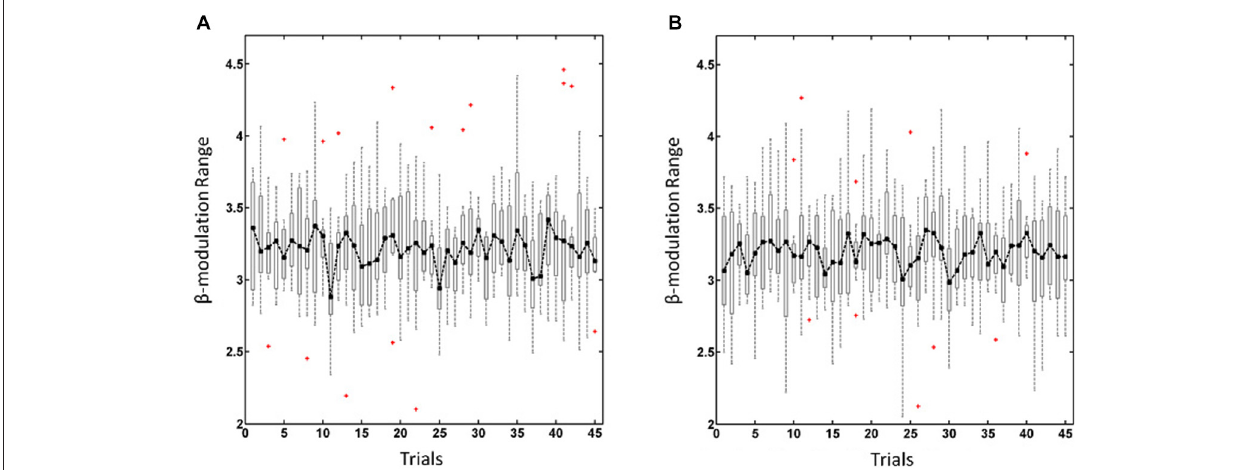
FIGURE 1 | β -modulation range for regulating the left hemisphere (A) and right hemisphere (B). Dot-dashed line and boxplots show the median and the range, respectively, of the overall β -modulation, i.e., for the haptic and visual feedback sessions, across trials with red crosses indicating outliers.